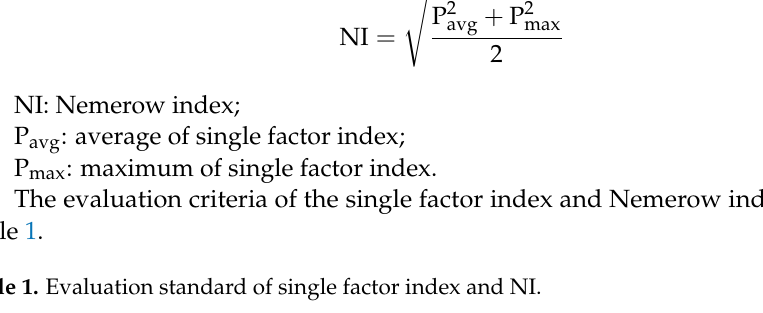
Table 1. Evaluation standard of single factor index and NI. Range of Pi or NI Extent of Contamination ≤ 1 safe (1, 2] slight contamination (2, 3] moderate contamination